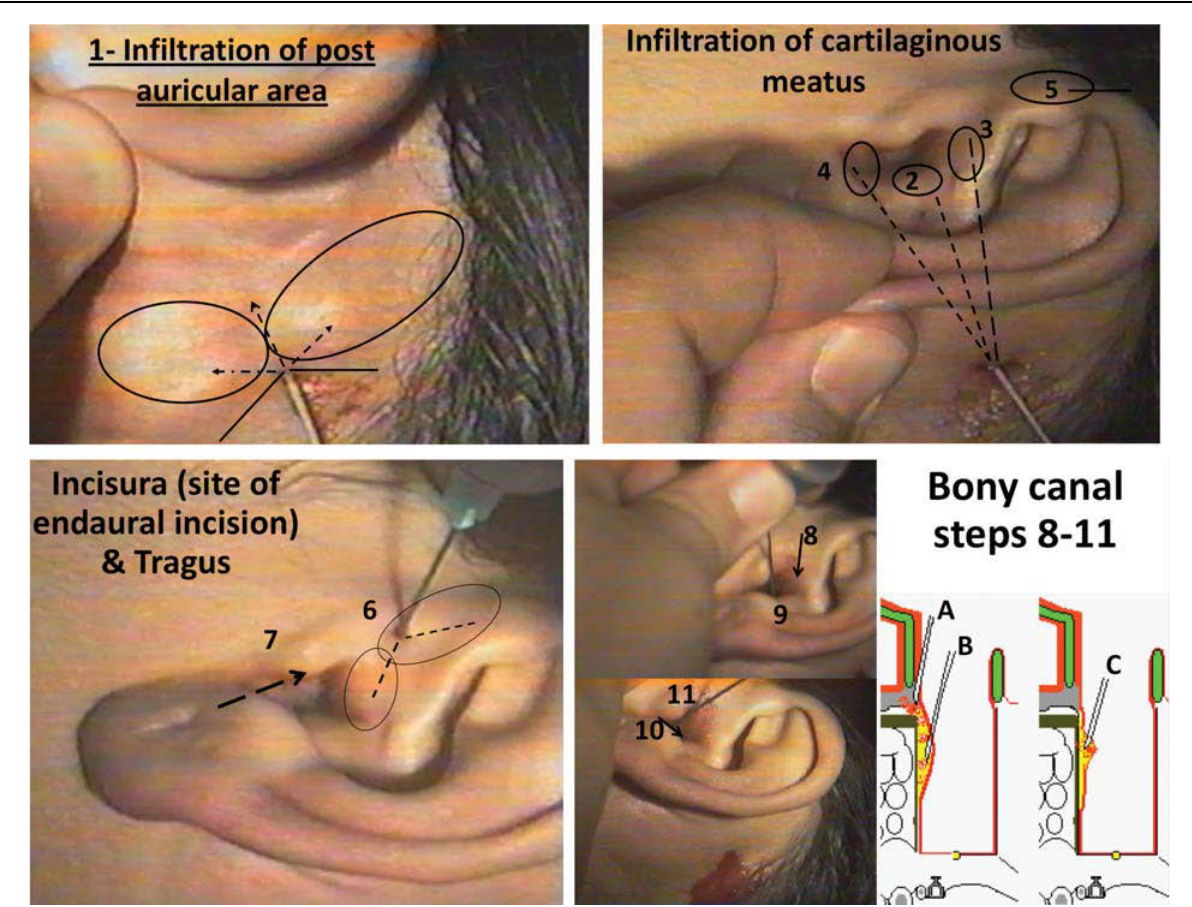
Points of infiltration of the ear for local anesthesia: (1) postauricular area, (2,3,4) posterior, superior, and inferior walls of the cartilaginous meatus, respectively, (5) in-frontof the crus of helix (auriculotemporal nerve),(6) incisura, (7) tragus, (8, 9,DD 10, 11) superior, posterior, inferior, and anterior walls of the bone meatus, respectively. (A) Injecting the bone meatus through the skin overlying cartilaginous meatus, and proceeding subcutaneously. (B) Classical injection of the skin overlying the bony meatus. (C) Needle bevel directed wrongly to skin causing its